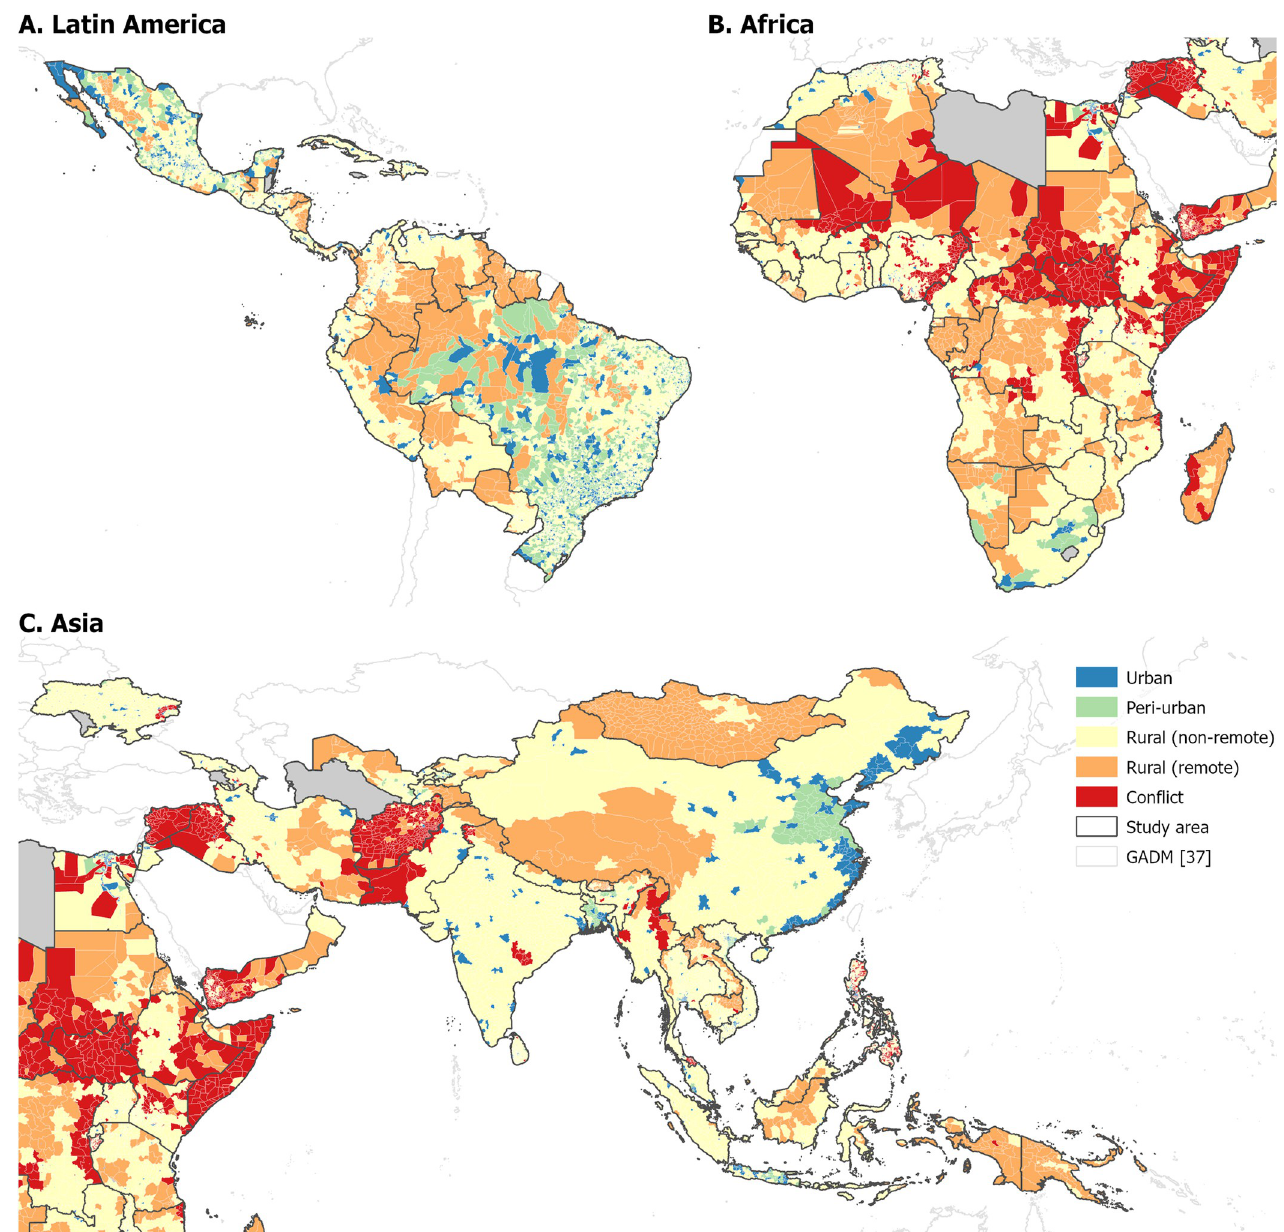
Fig 5. Map highlighting the geographical setting with the estimated greatest number of children under 1 years of age in 2019 not receiving DTP1 at GADM administrative level 2 [31, 37] for Latin America (A), Africa (B), and Asia